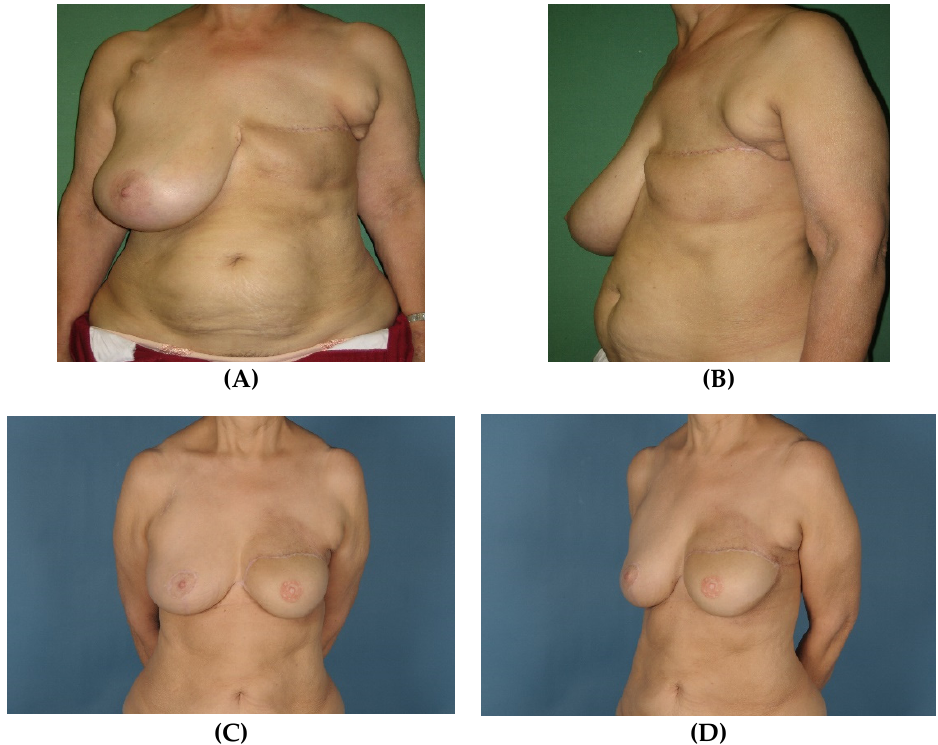
Figure 9. Pre- and one year postoperative results of Case 1. ( A ) On preoperative examination, front view. ( B ) On preoperative examination, side view. ( C ) On postoperative examination, front view. ( D ) On postoperative examination, side view.